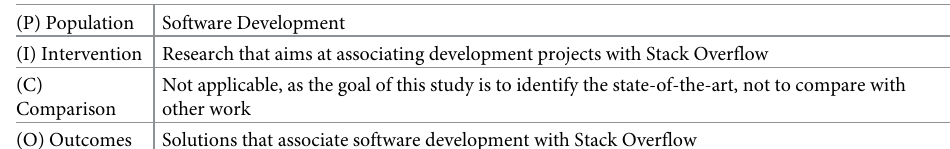
Table 1. PICO [31] for